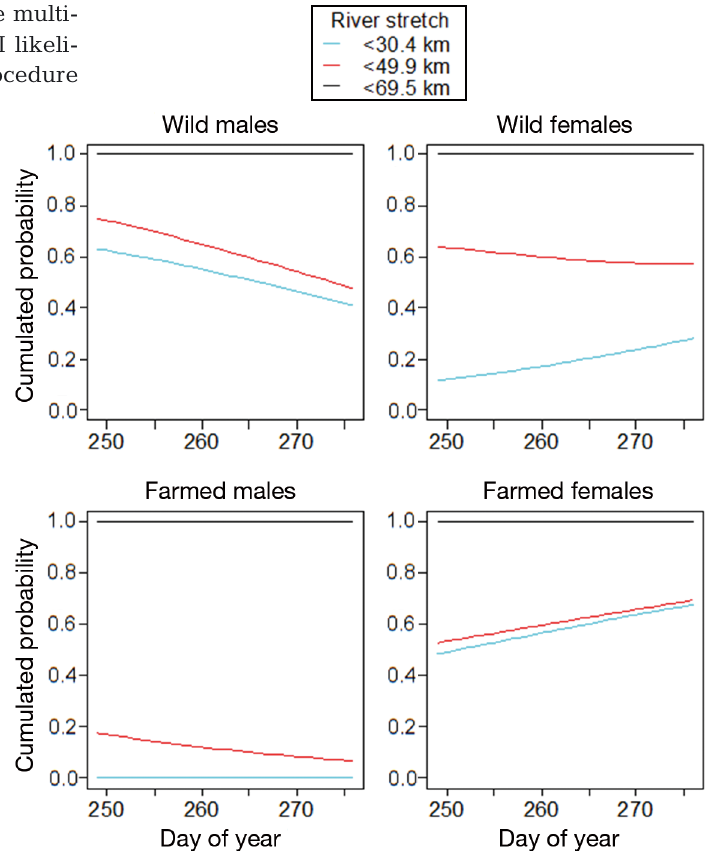
Fig. 3. Predicted probability of use of river stretches (zones) by Atlantic salmon Salmo salar in the pre-spawning period as a function of origin, sex and day of year. N = 11 wild females, 8 wild males, 5 farmed females, and 7 farmed males. Individuals of unknown sex were